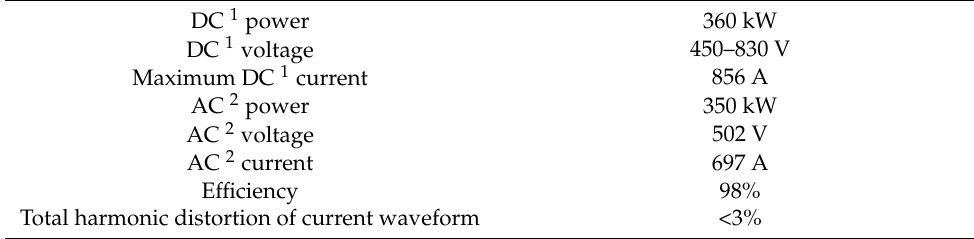
Table 1. Specifications of the converters.